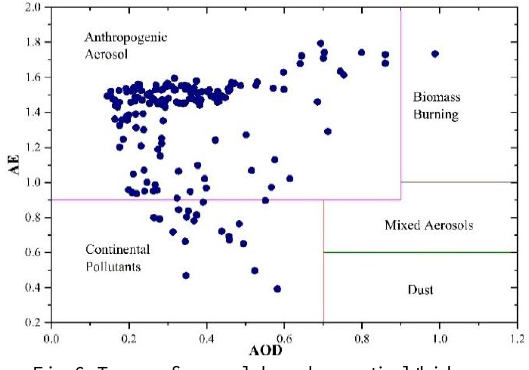
Fig. 6: Types of aerosols based on optical